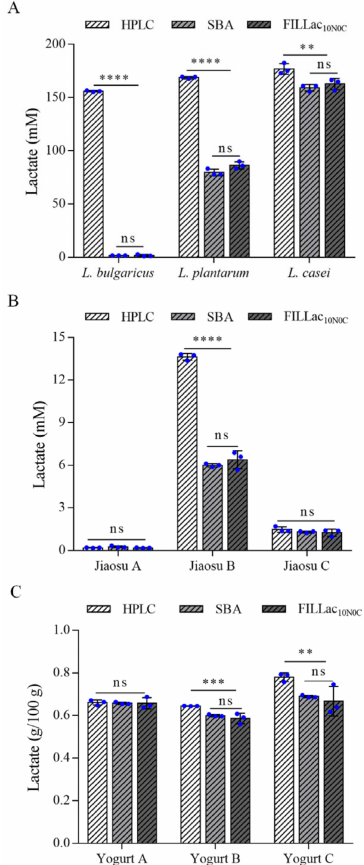
Figure 5. Quantification of L -lactate in various samples using the sensor FILLac 10N0C . ( A ) Comparison of the quantification results of lactate in fermentation samples produced by L. bulgaricus ATCC 11842, L. plantarum ATCC 14917 and L. casei ATCC 334 by HPLC, SBA-40D bioanalyzer, and FILLac 10N0C . ( B ) Comparison of the quantification results of lactate in three Jiaosu samples by HPLC, SBA-40D bioanalyzer and FILLac 10N0C . ( C ) Comparison of the quantification results of lactate in three yogurt samples by HPLC, SBA-40D bioanalyzer and FILLac 10N0C . All data shown are mean ± s.d. ( n =